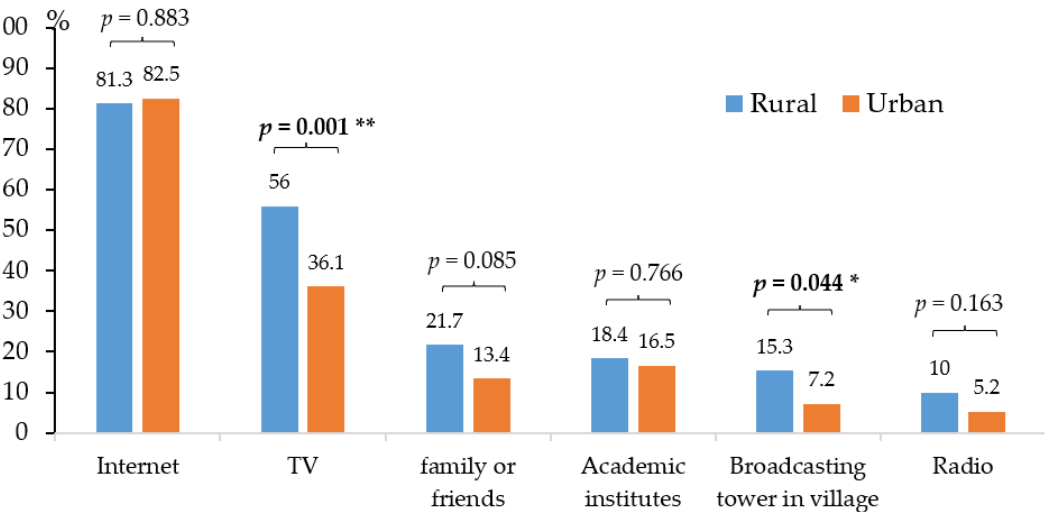
Figure 2. Source of information regarding reducing pesticide residues in VF, * p value < 0.05, ** p value < 0.01.